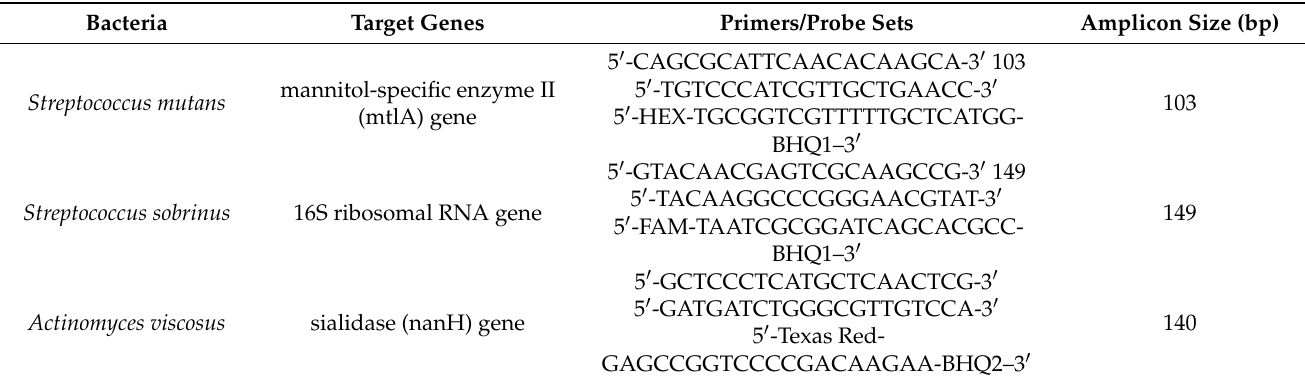
Table 1. Primers and probes used in the real-time PCR assays.